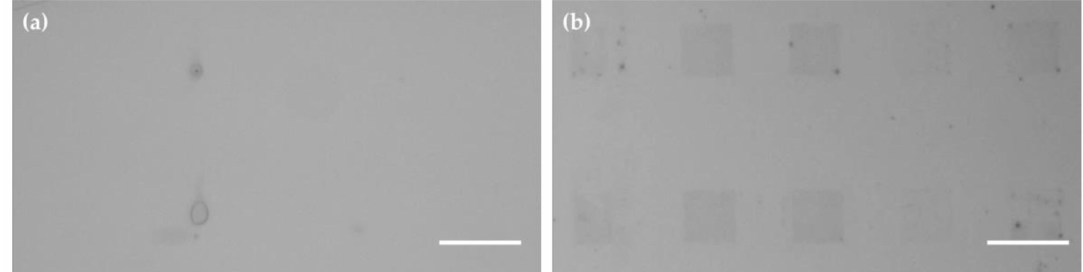
Figure 4. Visibility of lipid patch arrays in bright field microscopy. Array of 30 × 30 µ m 2 square-shaped lipid patches ( a ) on glass and ( b ) on block-type MPC copolymer substrates. While the lipid membrane stacks are visible on the block-type MPC copolymer due to their relative higher thickness, the array features are not discernable on the glass substrate. Here, only thick droplets of lipid are visible. Scale bars equal 50 µ